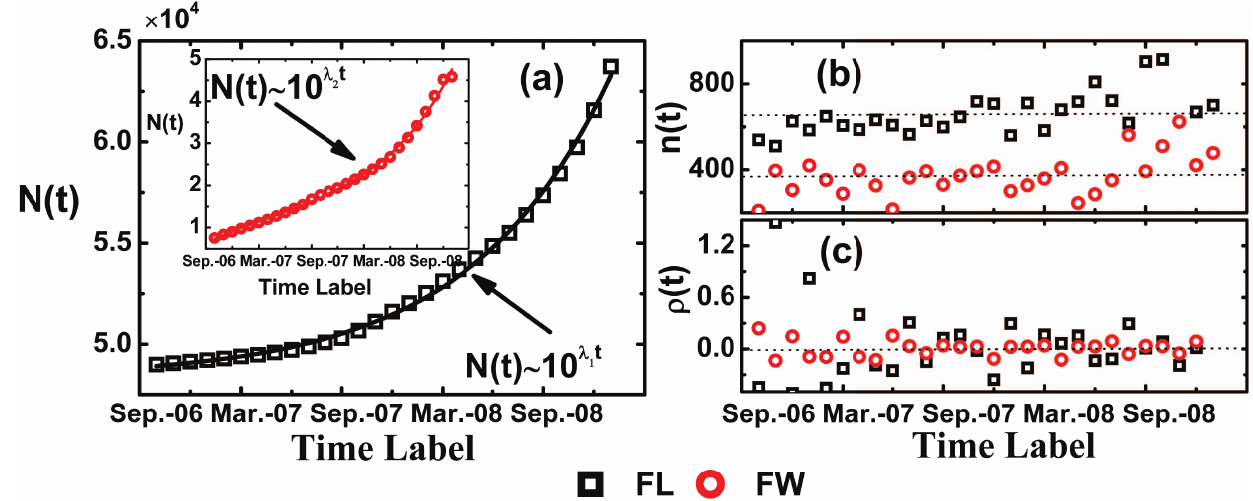
Figure 2. (Color online) Statistical properties of the network size N(t) (a) and the corresponding network core sizes n(t) (b), as well as the relative growth rate p(t) (c). (a) The growing tendency of the size N(t) of the FL and FW networks obey an exponential form with exponent